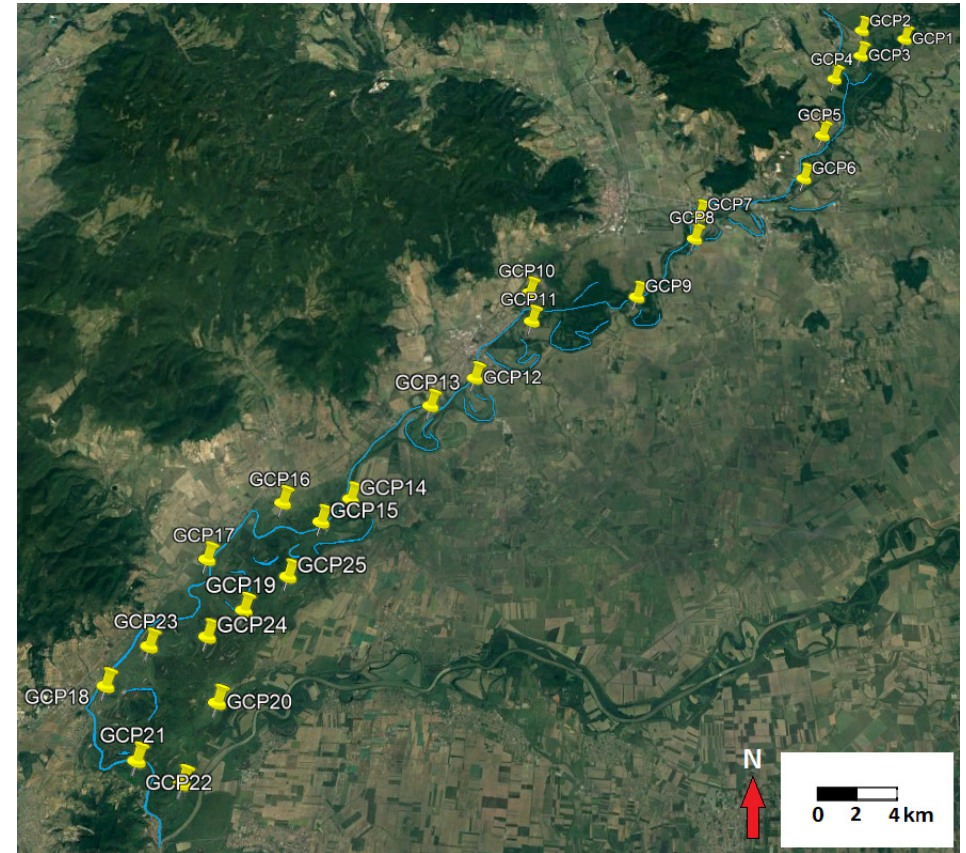
Figure 5. Graphic representation of ground control points based on Sentinel-2 image.